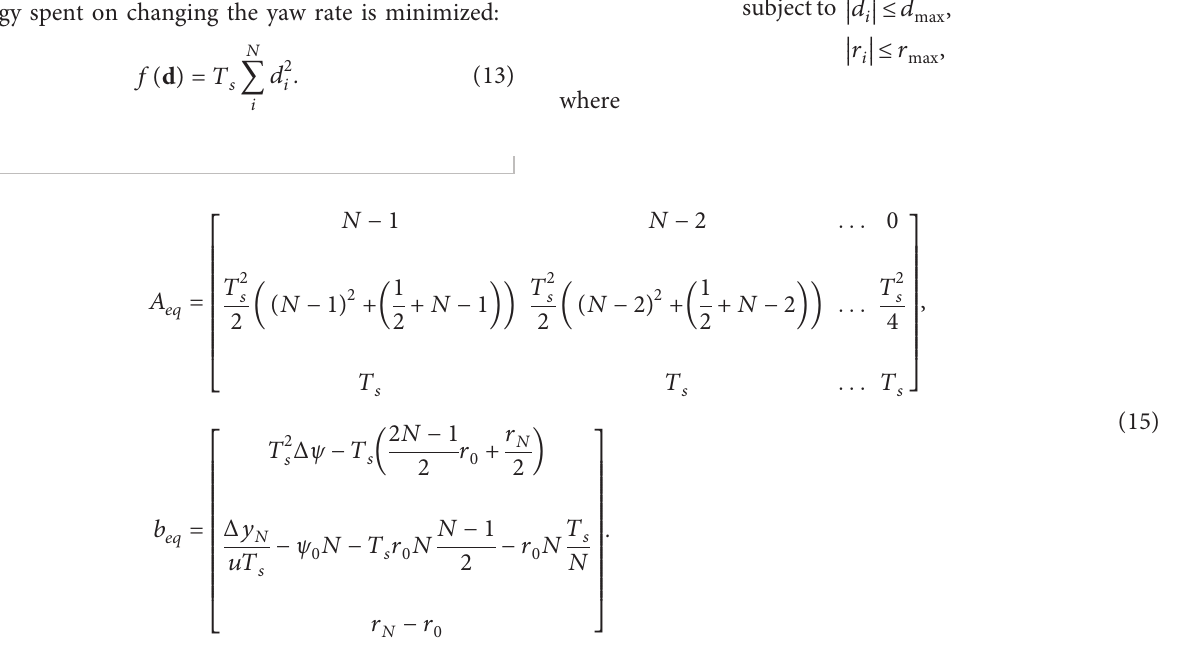
Figure 4. The structure formulates the internal model control (IMC) scheme: the two-track model presented in Section 2